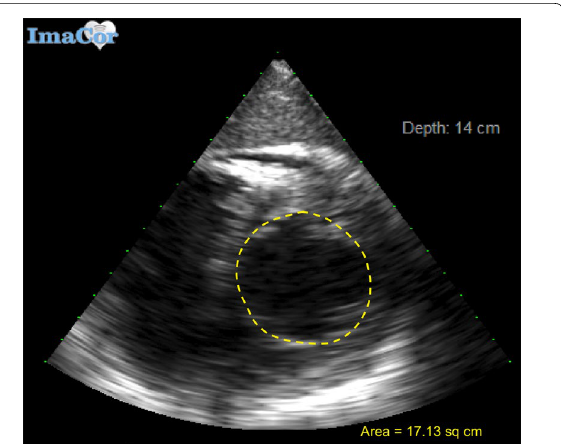
Fig. 1 Transesophageal echocardiographic view demonstrating transverse and posteroanterior measurements of left ventricle in end‑diastole